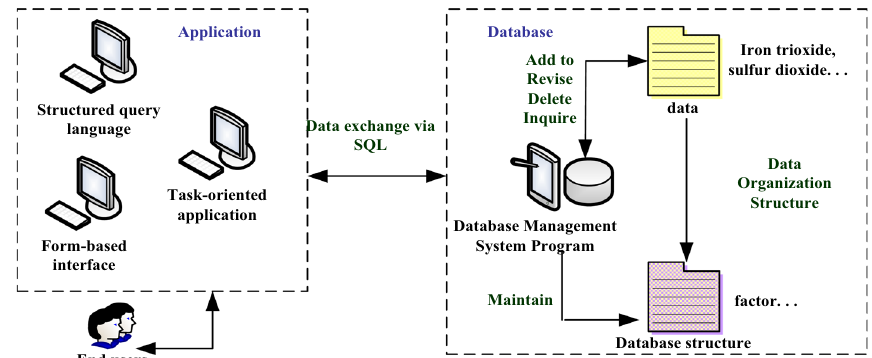
Fig. 1 Product cycle data